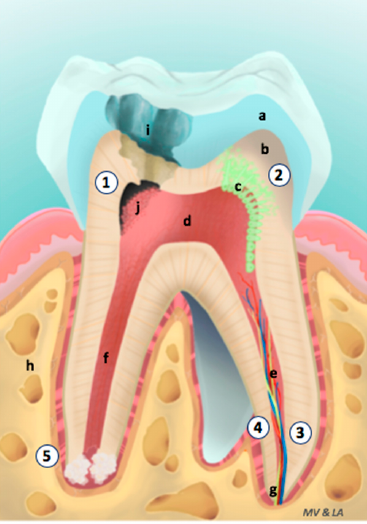
Figure 1. Levels of endodontic regeneration. 1; Pulp Connective tissue Formation, 2; Dentin Formation, 3; Revascularization, 4; Reinnervation, 5; Radicular Edification. a: Enamel, b: Dentin,